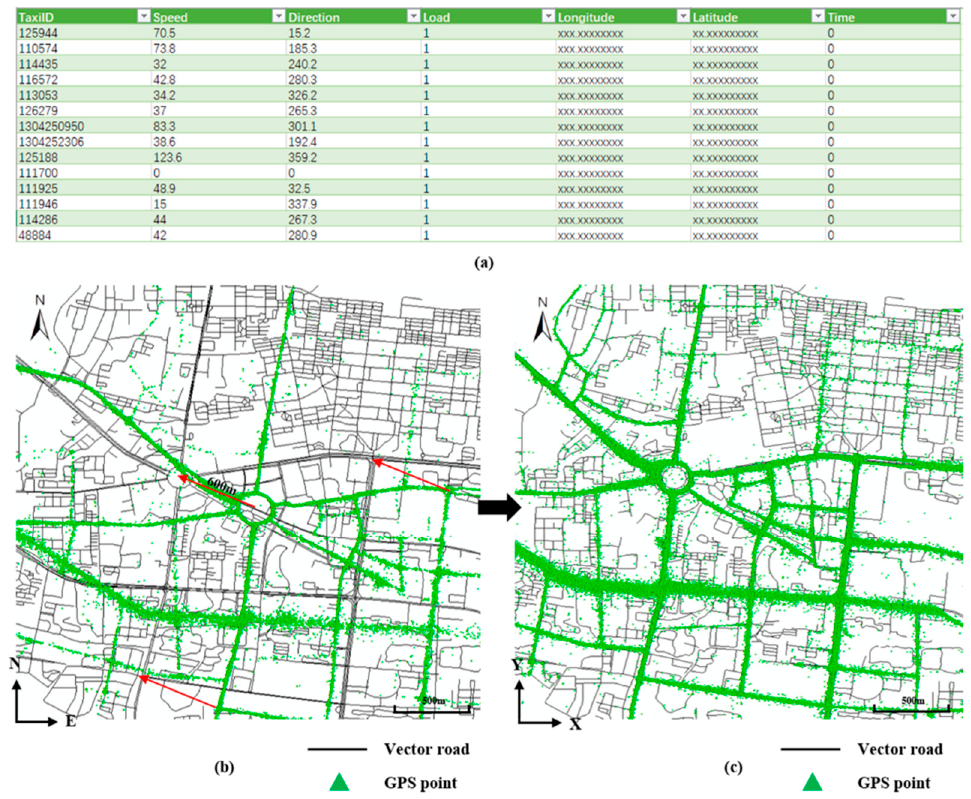
Figure 2. GPS point file and spatial coordinate transformation. ( a ) An example of a GPS trajectory point data file. ( b ) The location drift between GCJ-02 and WGS-84 is about 600 m. ( c ) GPS trajectory points and vector road data have the same location in the WGS84-World-Mercator projection coordinate system.